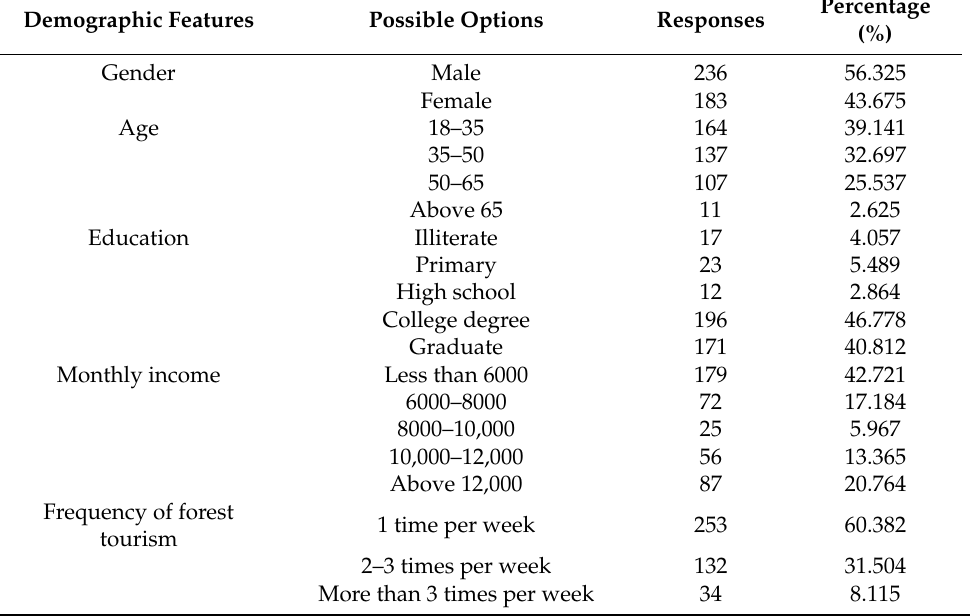
Table 2. Participant